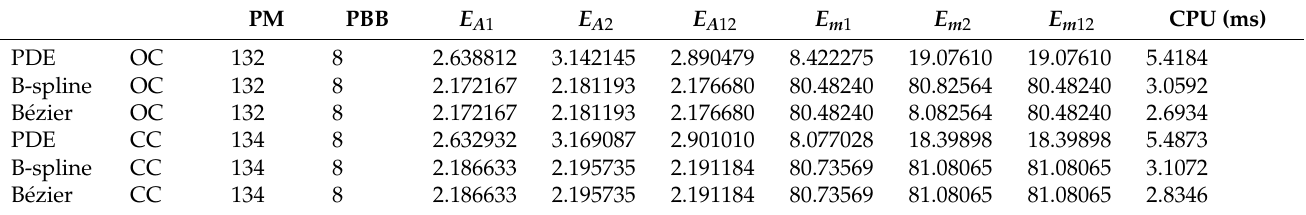
Table 3. Design variables, errors ( × 10 − 4 ), and computational time (CPU) for reconstruction shown in Figure